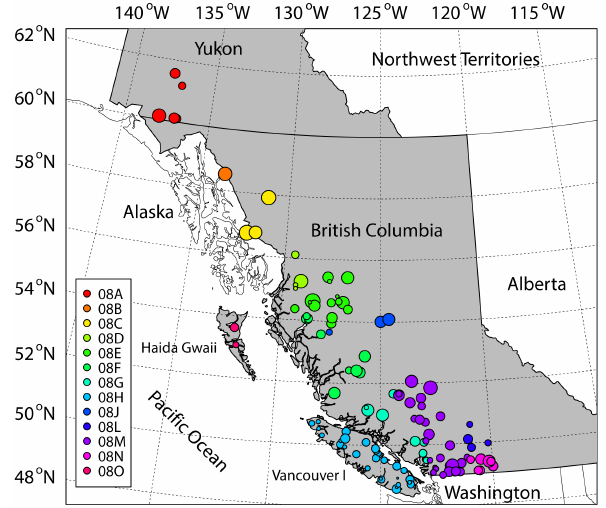
Figure 2. Map of the Canadian west coast showing the 127 Water Survey of Canada (WSC) streamflow gauging stations used in this study. The stations are coloured according to the first three charac- ters in the WSC naming convention (example – 08M), which defines the stations according to subdivisions of the major drainage basins. The size of each circle scales with the logarithm of the drainage area. The streamflow database was subsetted for stations draining the Coast